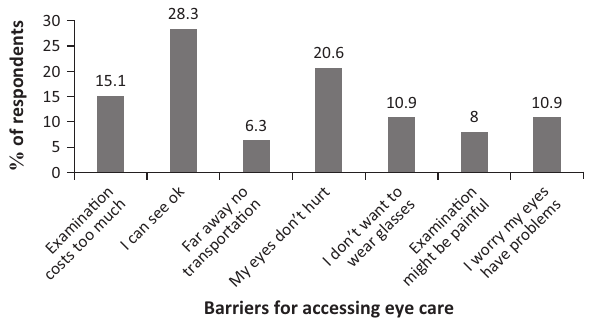
FIGURE 2: Have you got any information related to eye health?